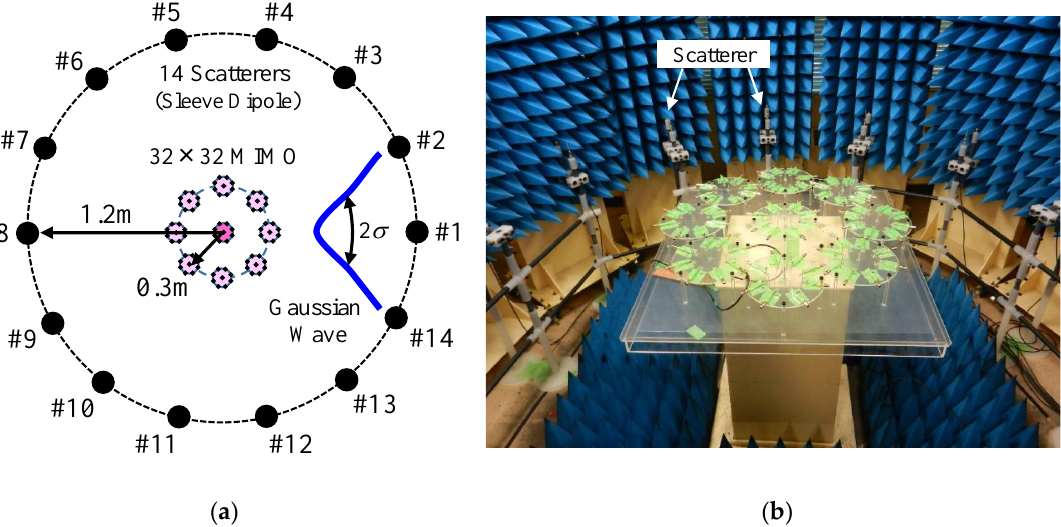
Figure 21. OTA testing of a 32 × 32 daisy chain MIMO antenna. ( a ) Two-dimensional fading emulator. ( b ) External view.